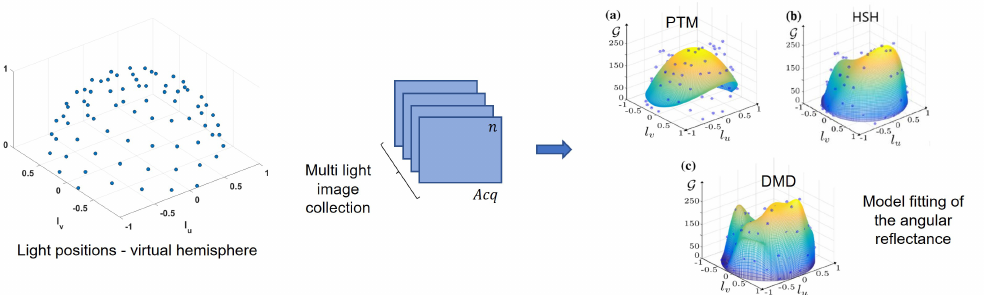
Figure 1. Reflectance transformation imaging technique. An example of the per pixel reflectance modeling using is shown here ( a ) PTM, ( b ) HSH and ( c ) DMD. These modelling plots are reprinted with permission from Pitard et al.